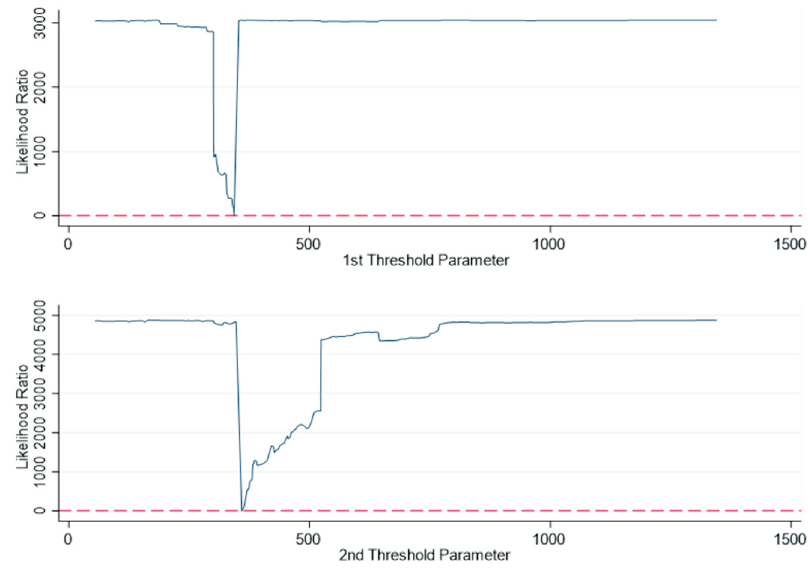
Figure 3. Test chart of the double-threshold effect.